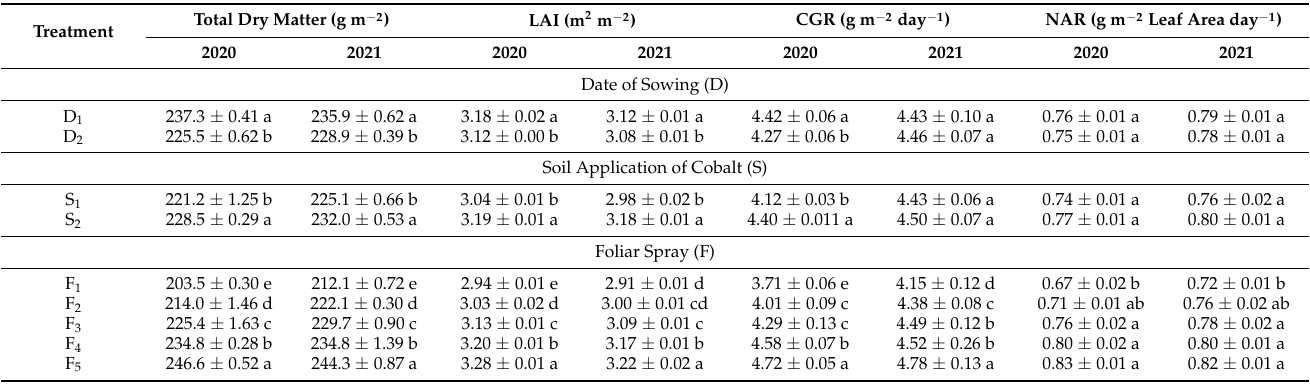
Table 5. Growth parameters of black gram influenced by date of sowing and nutrients application. Treatment